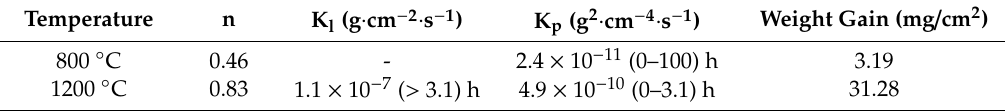
Figure 4. Thermogravimetry (TG) plots of the alloy OHS1 for isothermal oxidation in air at ( a ) 800 and ( b ) 1200 ◦ C. Table 3. Total weight gain and oxidation rate constants of OHS1 at 800 and 1200 ◦